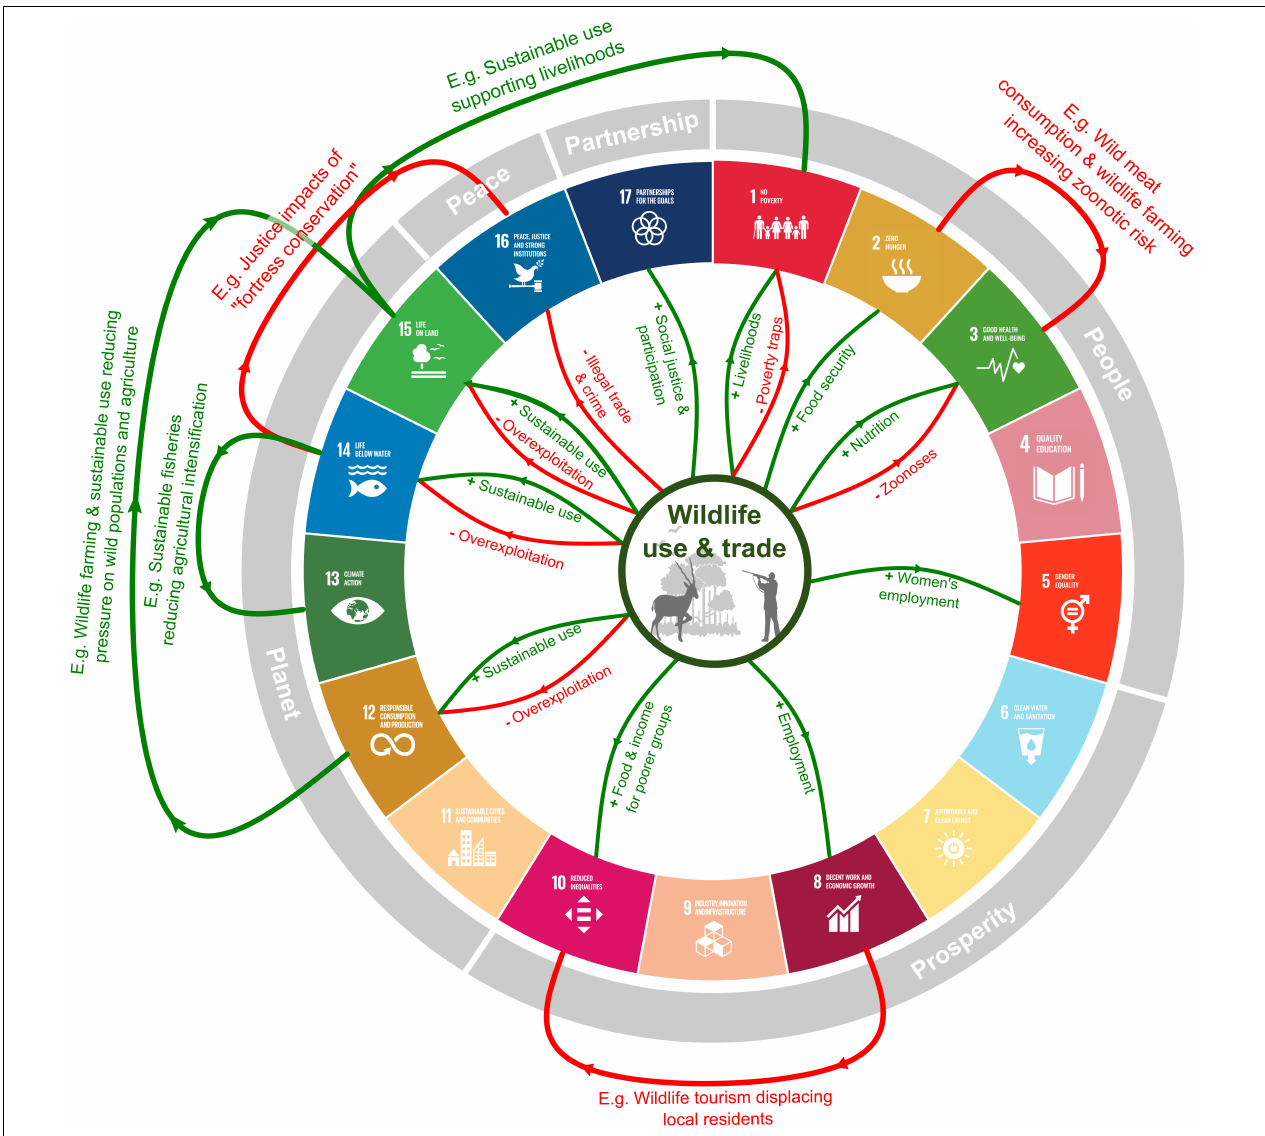
FIGURE 1 | Illustrative examples of some general positive (green) and negative (red) contributions of wildlife trade to the Sustainable Development Goals (SDGs). Direct contributions are denoted by arrows in the center of the diagram, while interactions between the SDGs are denoted by arrows around the outside (with trade-offs in red and synergies in green). This diagram is illustrative only; it is not intended to provide a complete review of all types of wildlife uses and trades, and their contributions and interactions.